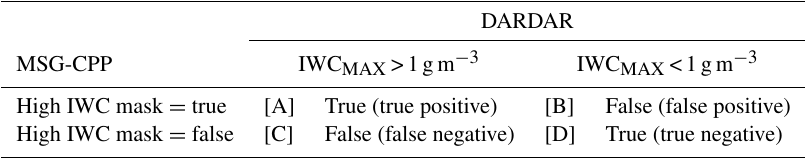
Table 1. Decision table for MSG-CPP high IWC mask.